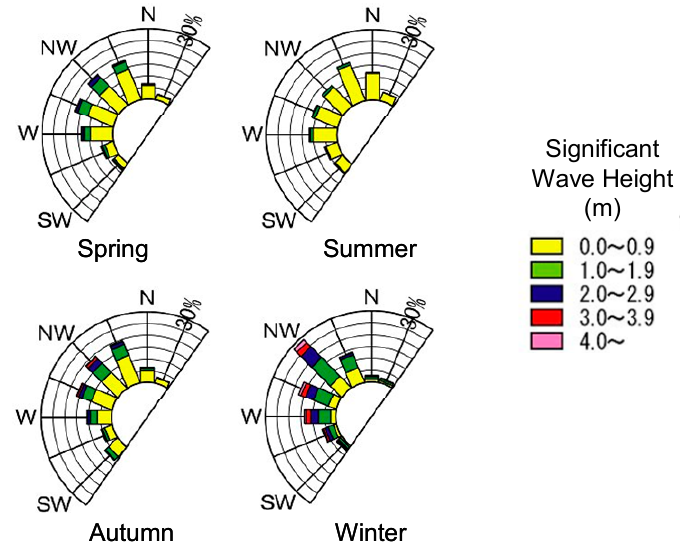
Figure 3. Wave climate observed at Tokumitsu Station (1995 to 2005).